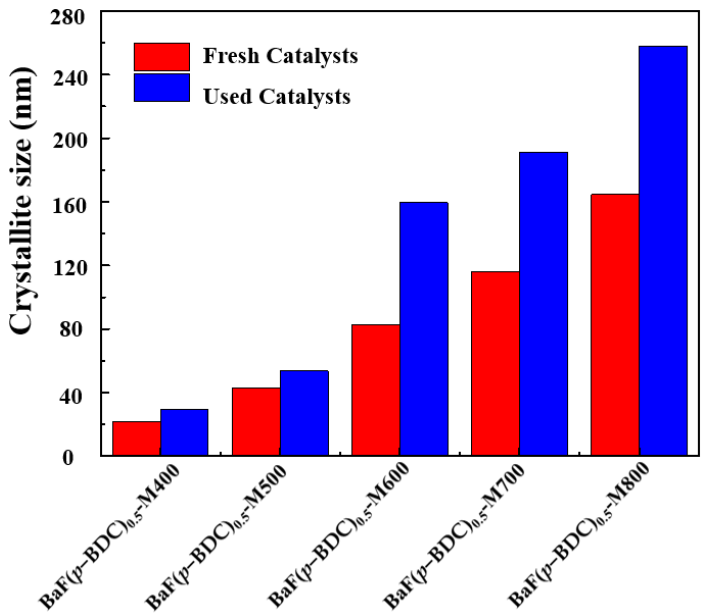
Figure 6. The crystal size of fresh and used